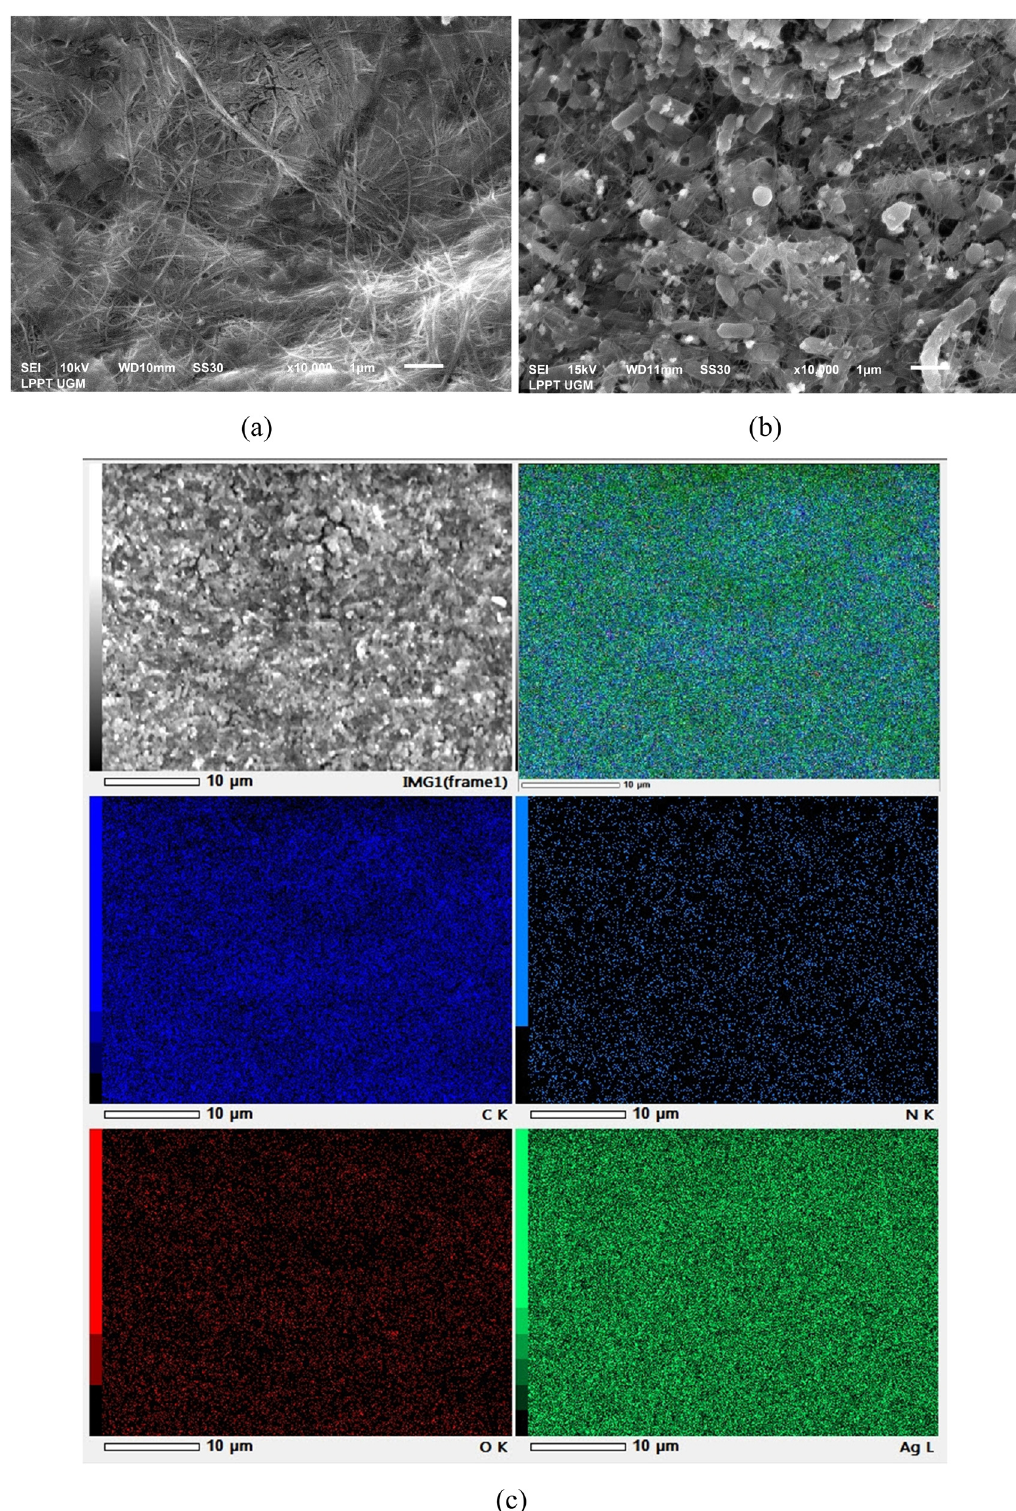
Figure 5: SEM image of: ( a ) pristine BC, ( b ) AgNP15@BC, and ( c ) its elemental